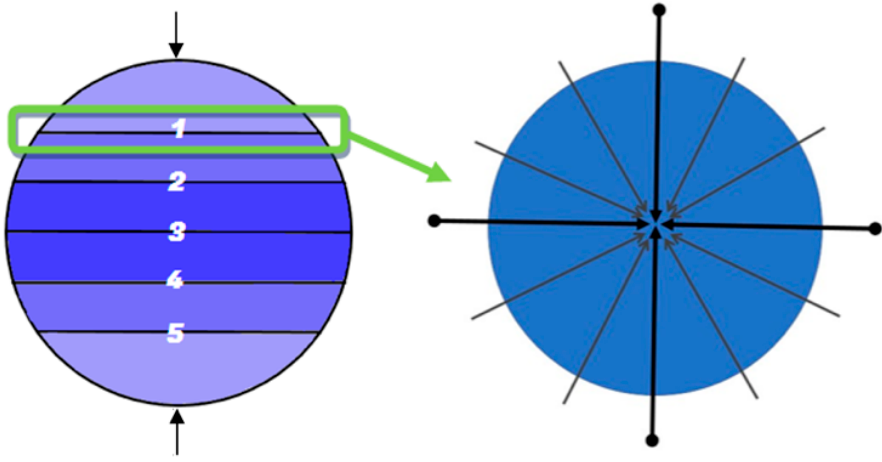
Figure 2. Schematic diagram of viewpoint distribution of source point cloud. According to the maximum entropy theory, the images collected from the 62 view- points are calculated. The entropy values obtained from each viewpoint are shown in Figure 3a. The best viewpoint (b) is the blue box θ = 120 ◦ , ϕ = 60 ◦ , with a value of 3.72, and the worst viewpoint (c) is the red box θ = 210 ◦ , ϕ = 30 ◦ , with a value of 0.25. Therefore, we put (b) into the optimal viewpoint matching calculation as the input image of the source point